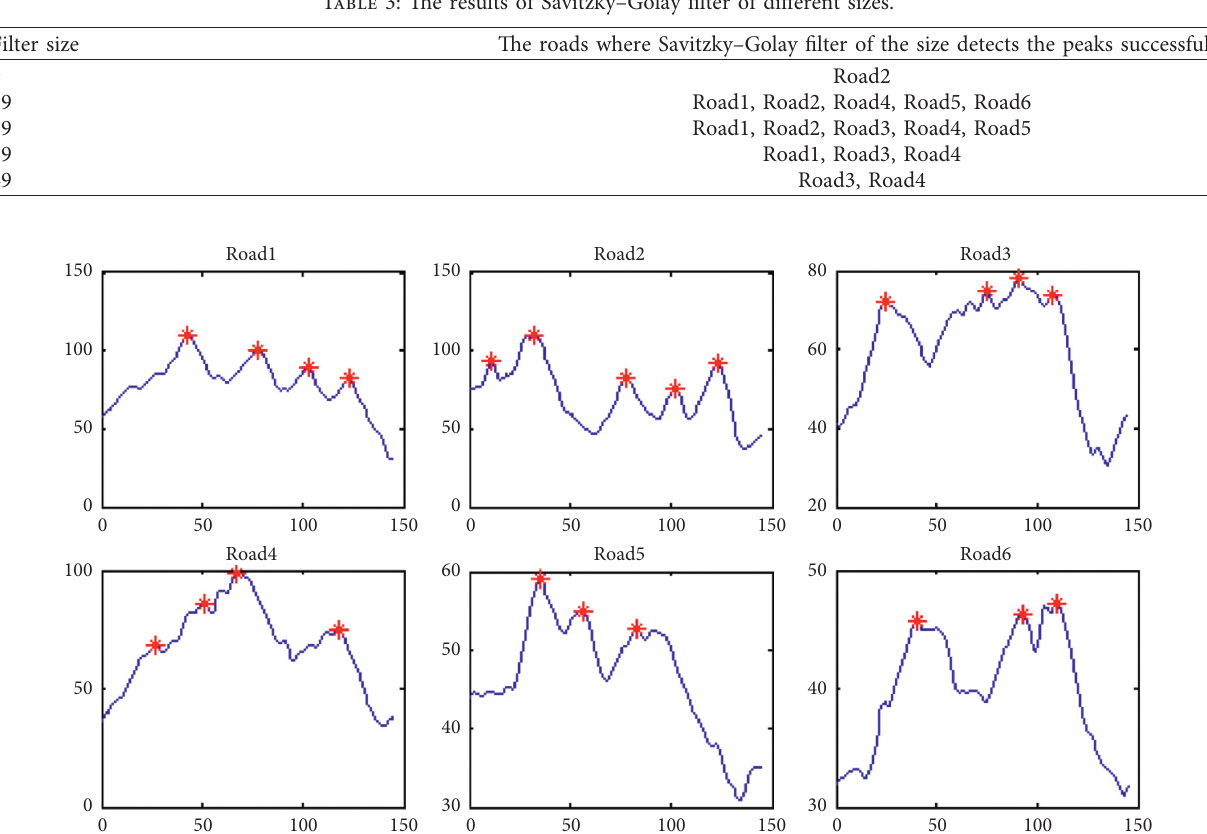
Figure 18: The data smoothed with the wavelet db4 and the peaks